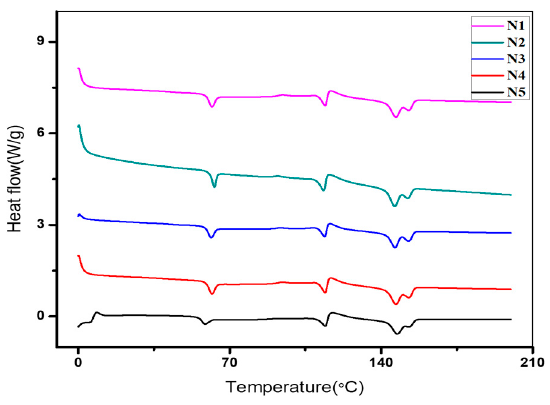
Figure 3. DSC of PLA-PBS, PLA-PBS-CNC composite films.